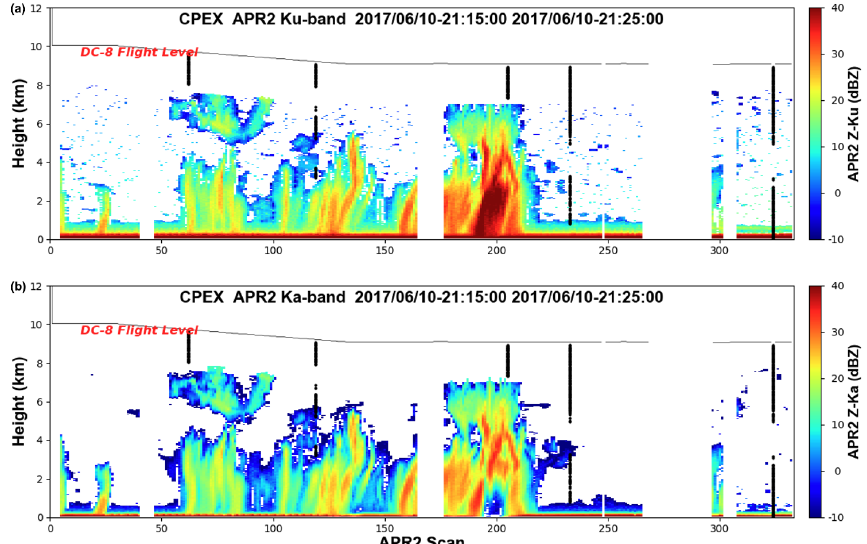
Figure 12. APR-2 measured radar reflectivity vertical profiles for the 10min DC-8 flight period between 21:15–21:25UTC. (a) Ku band. (b) Ka band. The spacing between each APR-2 scan is 360m. The black dots indicate DAWN wind profile